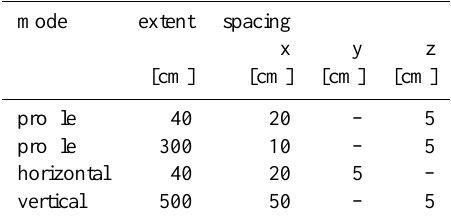
Table 2. Spacing and extent of measurement lay-outs as shown in Fig. 4 (concept according to Bl¨oschl, 1999). x-direction corre- sponds to horizontal distance, y-direction is distance between con- secutive measurements as in Fig. 4a, and z-direction is equivalent to snow depth measured vertically (in cm, Fig. 4b,